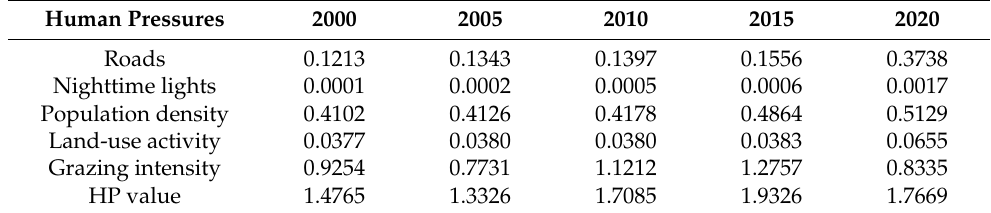
Table 3. Disturbance values of five HPs in the NRs of the Qinghai–Tibet Plateau for 2000–2020.